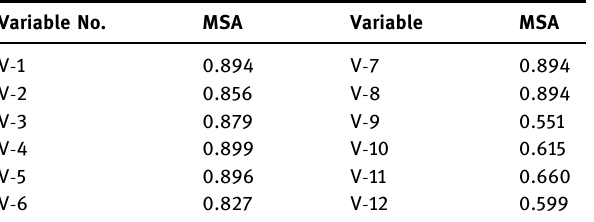
Table 4: Results of the FA solution with extraction by PCA and Varimax